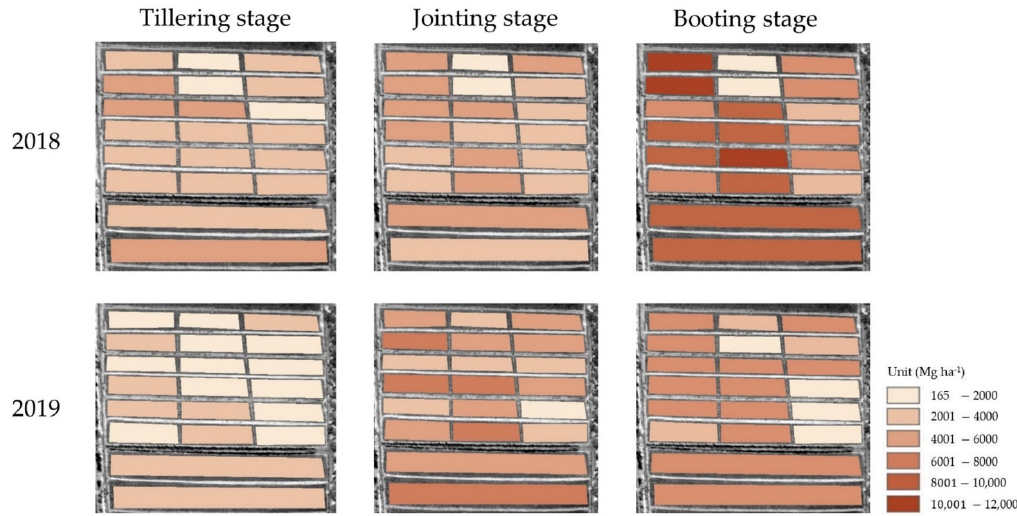
Figure 6. Maps of AGB estimations by growth stages in 2018 and 2019.